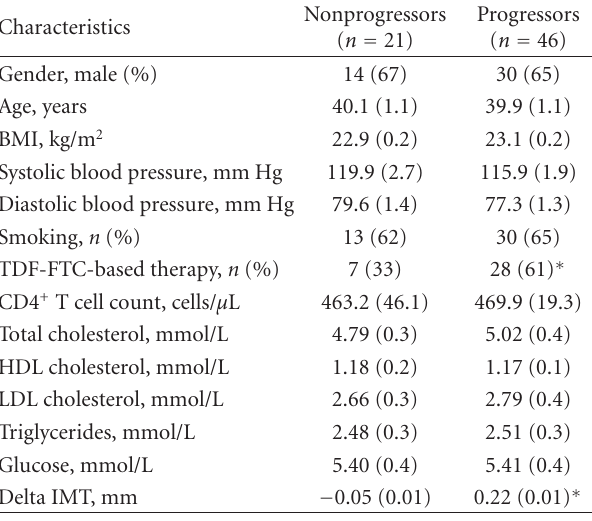
Table 2: Comparison of baseline values in groups segregated by the course of IMT.